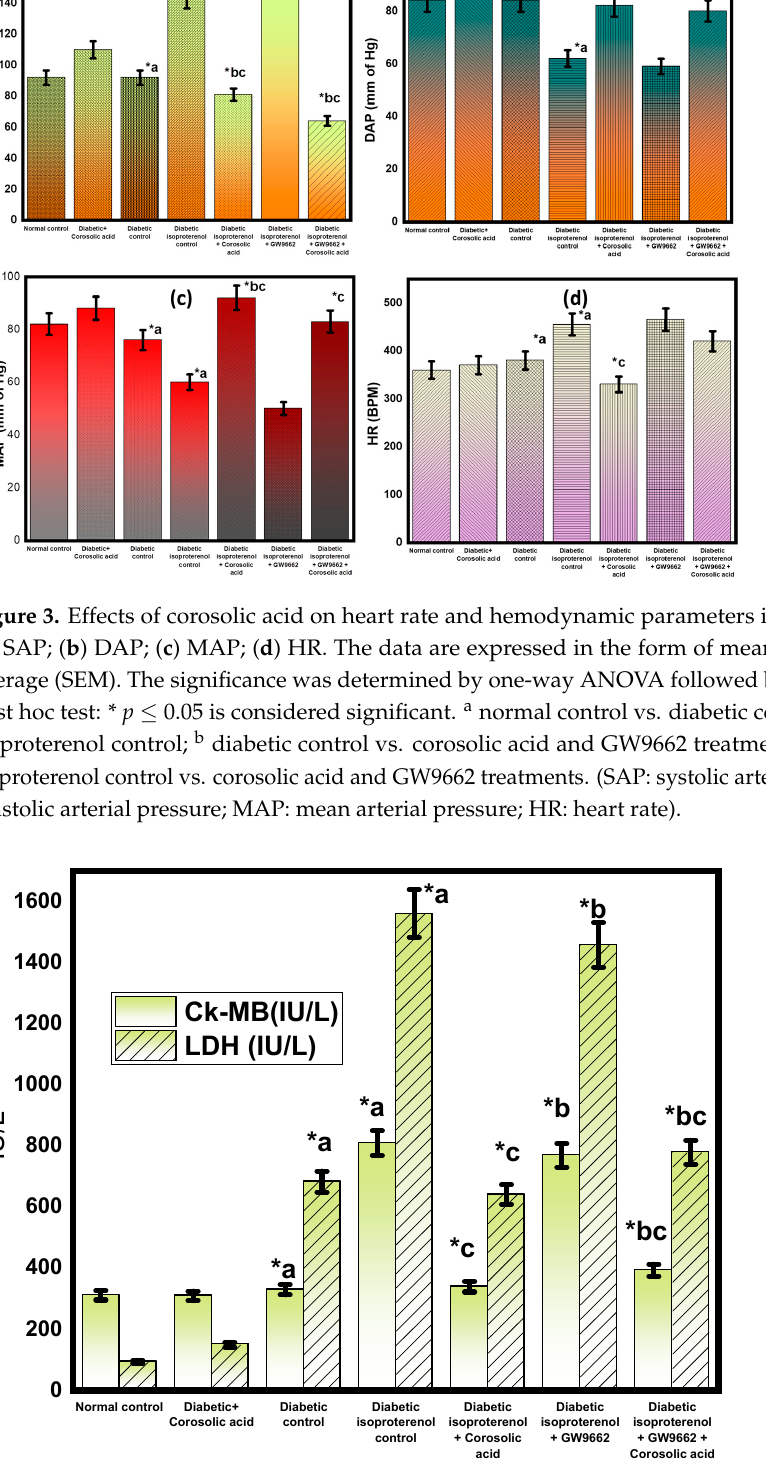
Figure 4. The effect of corosolic acid on the markers of heart disease in different groups. The data are expressed as mean ± SEM. * p ≤ 0.05 is considered significant. a normal control vs. diabetic control and diabetic isoproterenol control; b diabetic control vs. corosolic acid and GW9662 treatments; and c diabetic isoproterenol control vs. corosolic acid and GW9662 treatments. (IU: international unit; CK ‐ MB: creatine kinase on myocardial bundle; LDH: lactate dehydrogenase).